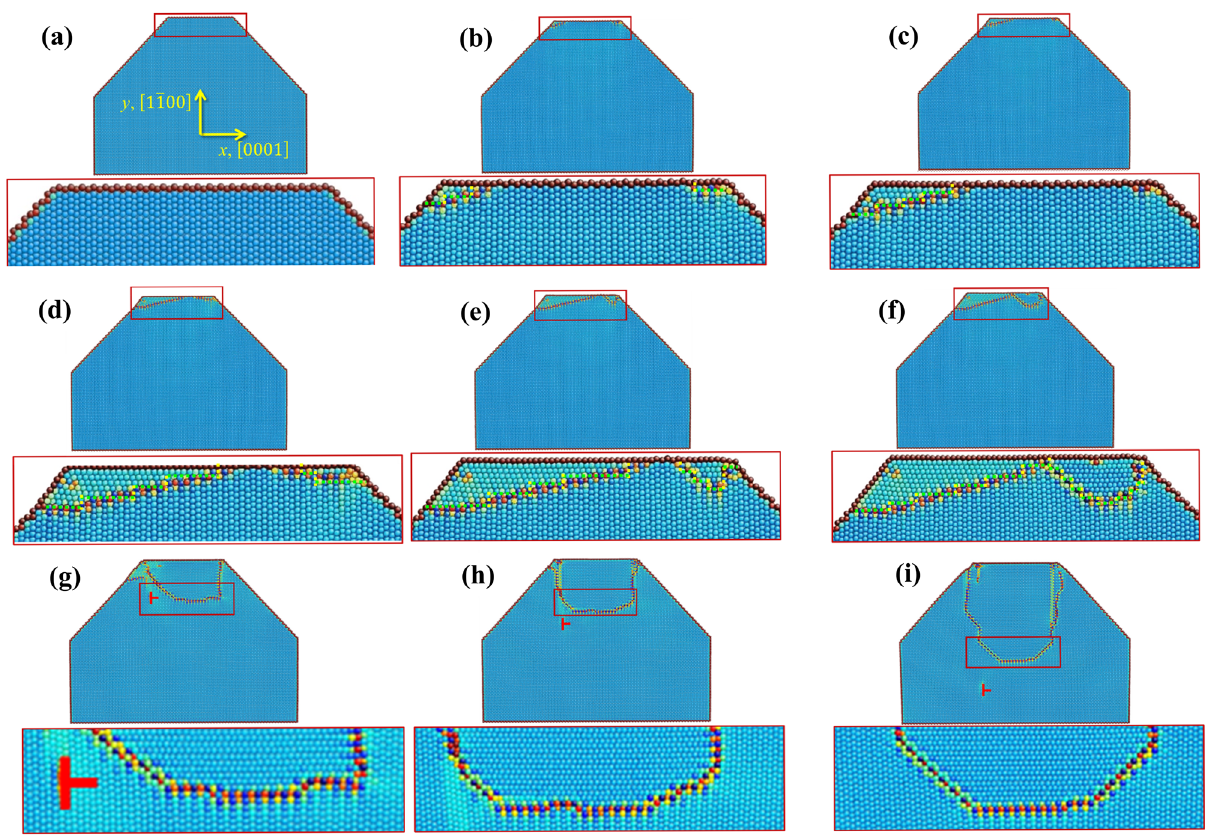
Fig. 4 Molecular dynamic simulations of twin nucleation. a Initial relaxed single crystal. b – d Nucleation of two twin nuclei at the corners on top surface. e – g Merge of two twin nuclei into a larger twin nucleus. h , i Propagation and growth of twin nucleus via migration of basal-prismatic (BP) and prismatic- basal (PB) interfaces. The symbol “ Τ ” indicates a basal < a > dislocation that is emitted from the PB interface. The bottom images of a – i are magni fi ed images in the pillar top region. The rectangles in each image indicate locations associated with the enlarged images. The twin nucleus is surrounded by PB and BP interfaces. In the enlarged images, the yellow dashed lines indicate the BP interfaces, and the green dashed lines indicate the PB interfaces. Atoms are color coded according to their excess energy, with the lowest energy atoms appearing blue, while the highest energy atoms appear